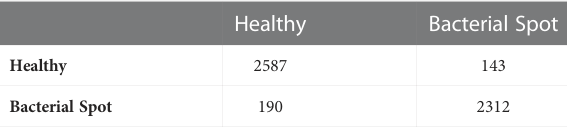
TABLE 7 Proposed model confusion matrix for Peppers plant disease classi fi cation.